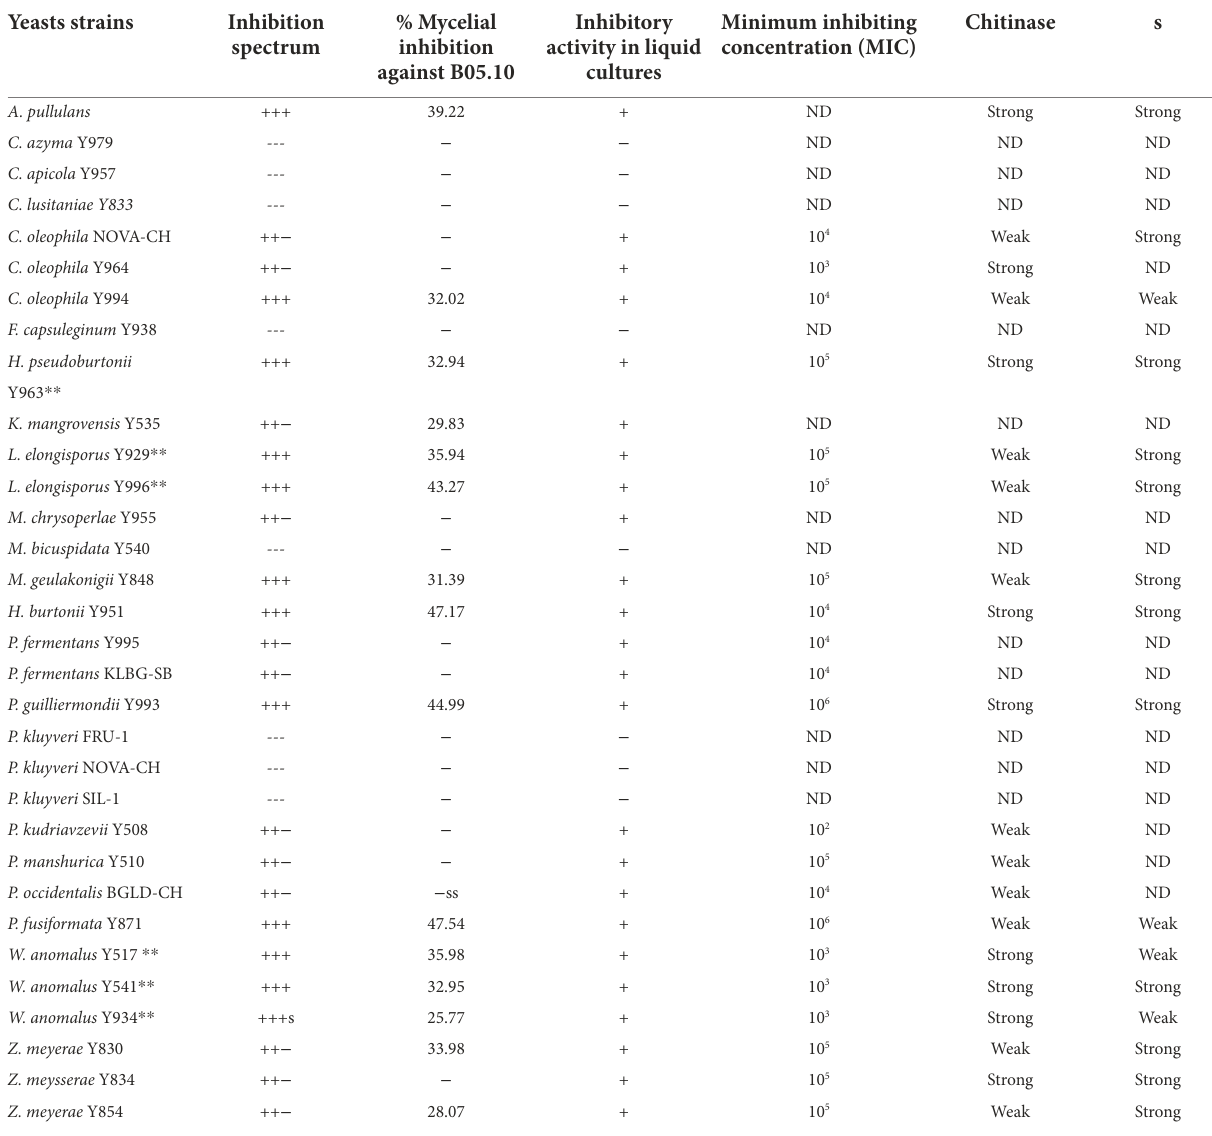
TABLE 2 Antifungal activity phenotypes of yeast species and strains. Yeasts